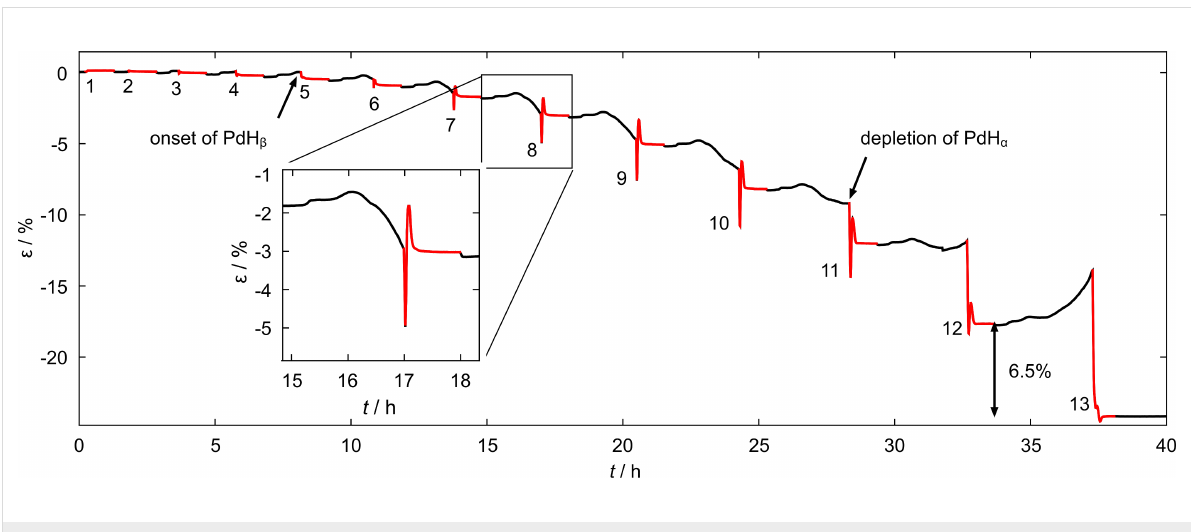
Figure 5: Strain ε as a function of the time t for a series of consecutive hydrogen absorption processes at a constant current of 1 mA and desorption processes at − 0.4 V in 1 M KOH for nanoporous palladium. Desorption processes are marked red, the amount of charge during hydrogen loading (black) was controlled via the sorption time and increased in steps of 1 A·s from 1 A·s to 13 A·s.